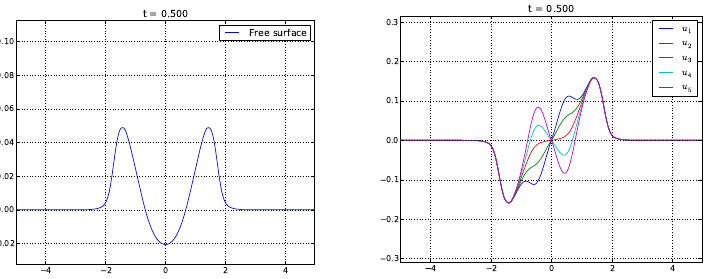
Figure 6. Free surface ( left ) and velocities ( right ) at time t = 0.5 s for the second order scheme. Table 1. Order of accuracy for the first order scheme.